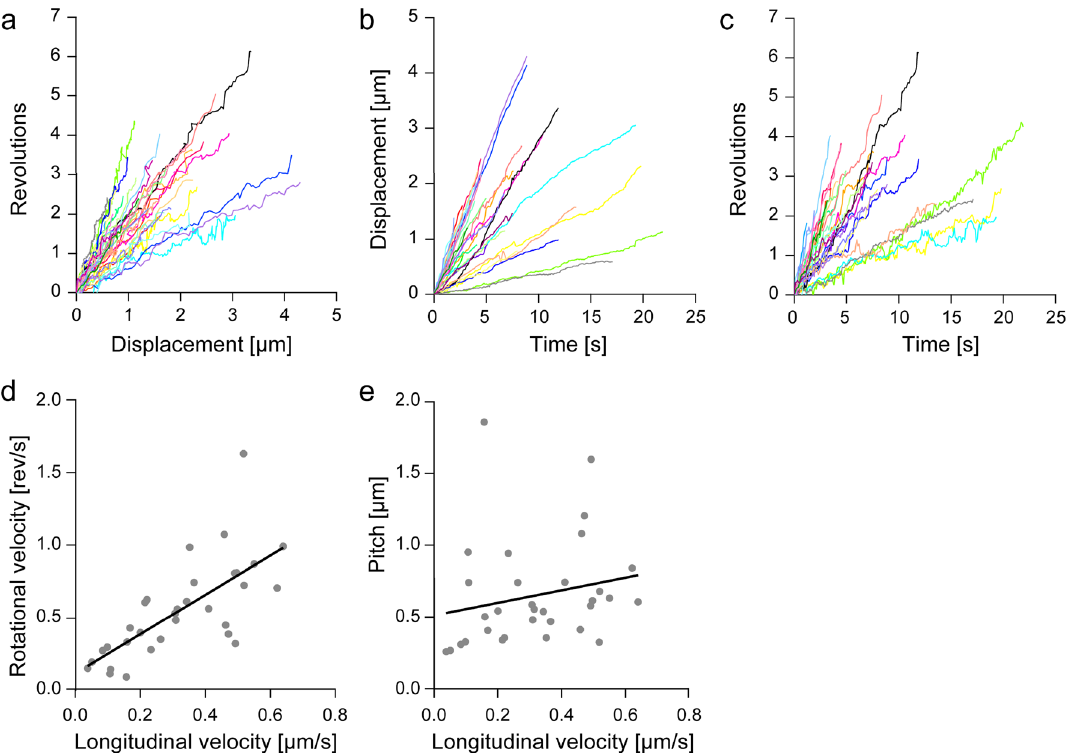
Figure 2. Helical motion of OAD-coated microbeads. ( a ) Cumulative revolutions plotted versus longitudinal displacement for OAD-coated microbeads ( n = 32). The rotation to the right with respect to the movement in the longitudinal direction is expressed as a positive number. The average pitch was + 0.65 ± 0.36 µm (mean ± SD). ( b, c ) Time course of longitudinal distances ( b ) and revolutions ( c ) of the microbeads ( n = 32). Individual trajectories in ( b ) and ( c ) were fitted with line functions to determine the longitudinal and rotational velocities, respectively. Average longitudinal and rotational velocities were 0.32 ± 0.17 µm s −1 and 0.55 ± 0.33 rev s −1 , respectively. ( d, e ) Correlation of rotational velocity and helical pitch with longitudinal velocity. The correlation coefficients, R and linear fit, R 2 , of the longitudinal and rotational velocities, and longitudinal velocity and helical pitch were R = 0.71; R 2 = 0.51 ( d ) and R = 0.21; R 2 = 0.04 ( e ) ( n = 32),